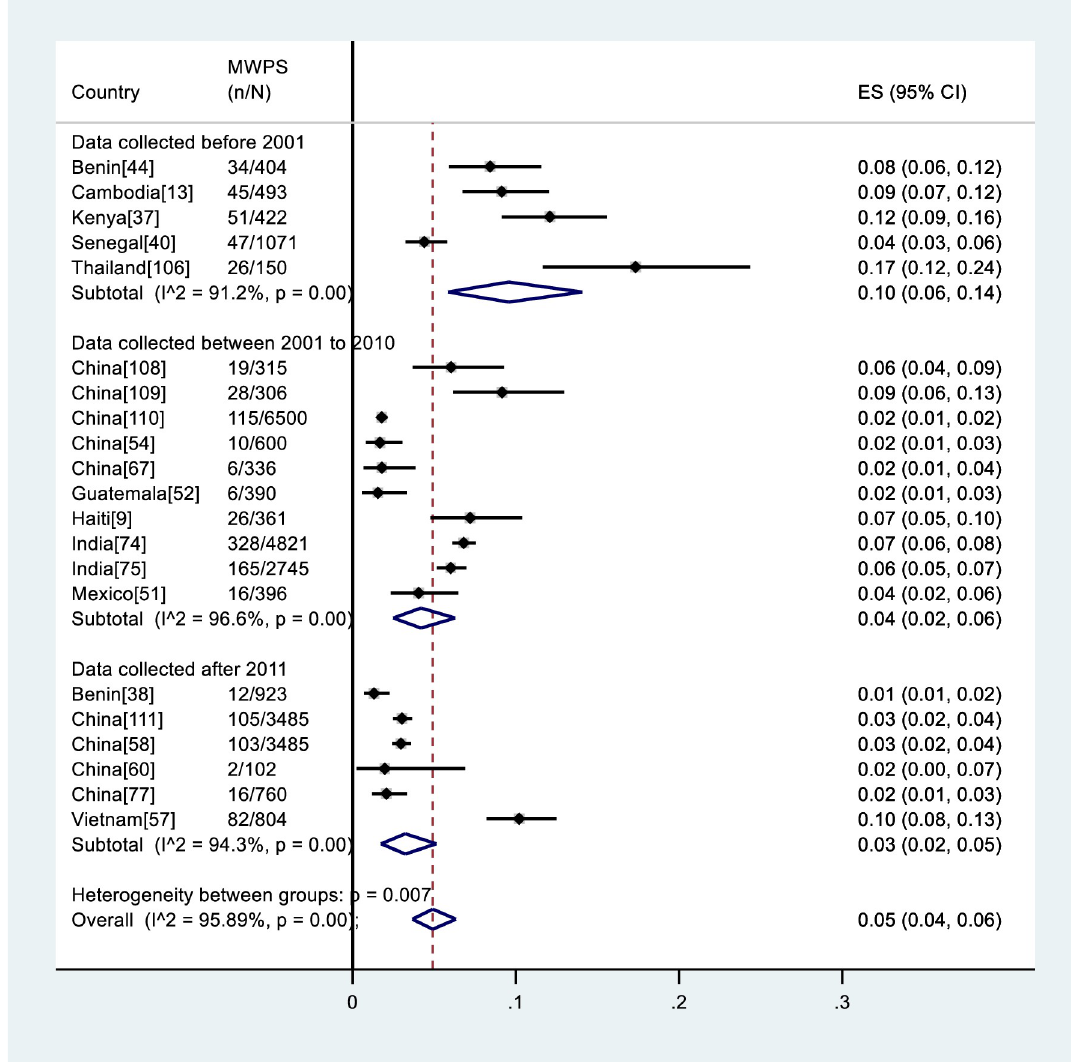
Fig 2. Meta-analysis of HIV prevalence among MWPS in LMICs by data collection period. ES: Estimated prevalence, n: Number of HIV positive, N: Number of